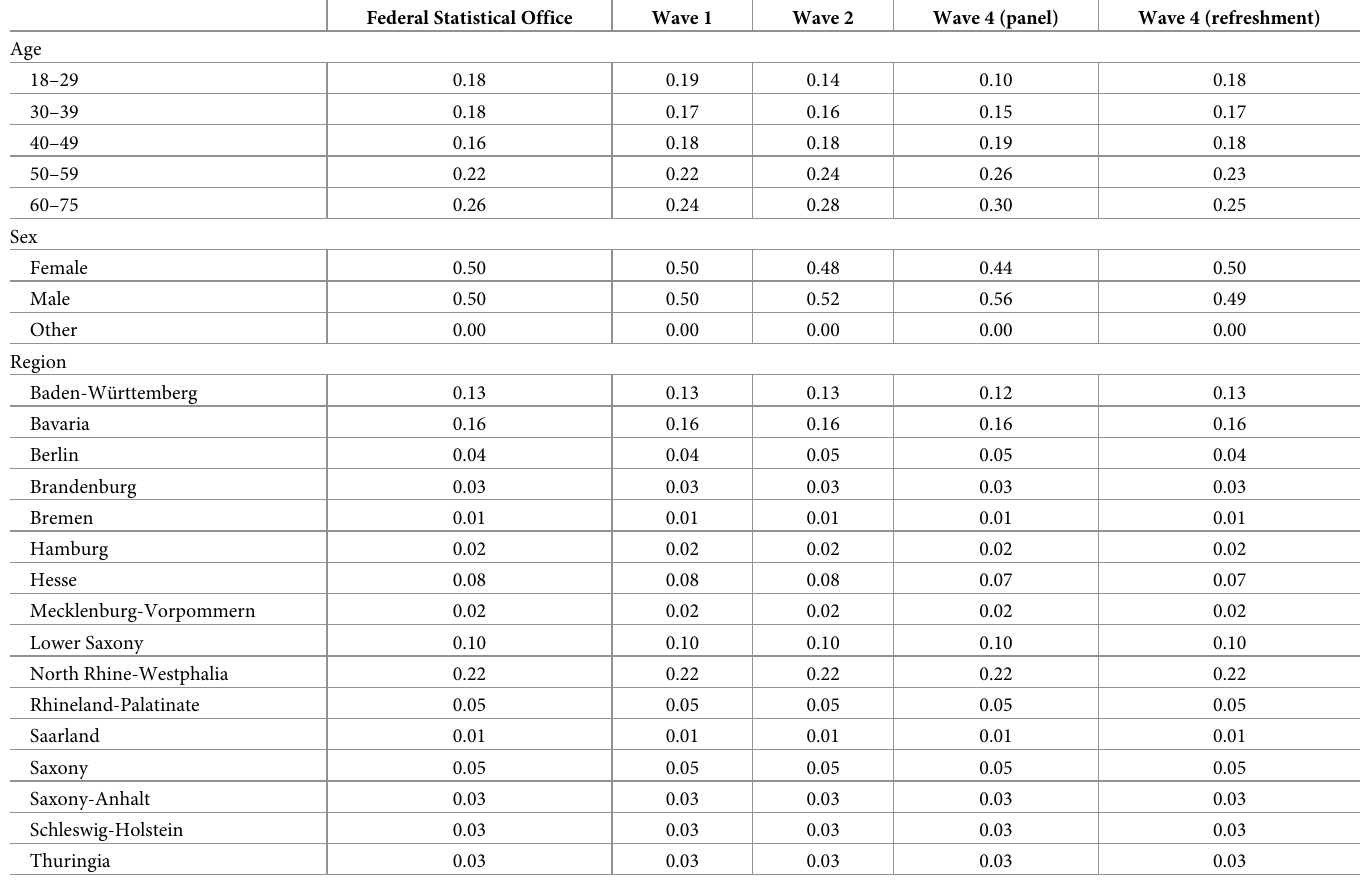
Table 1. Sociodemographic